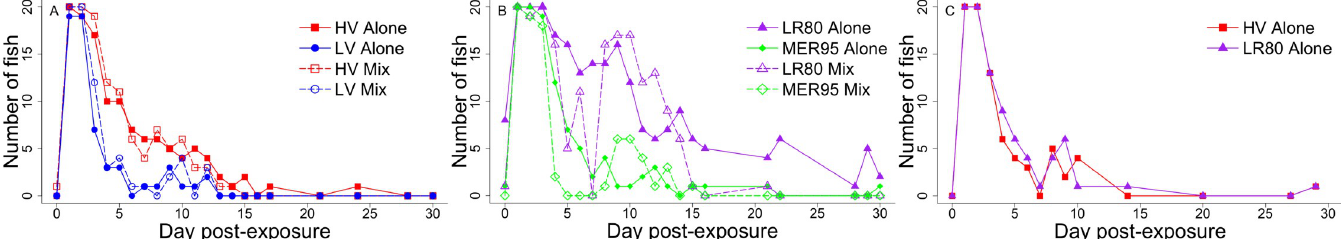
Fig 2. Number of fish shedding virus. Panels show number of remaining live fish shedding detectable quantities of IHNV RNA for genotypes HV (red), LV (blue), MER95 (green), LR80 (purple), in single (solid lines) or mixed infections (dashed lines), in experiments 1–3 (A-C, respectively). Mixed infections were not assessed in experiment 3. There were 20 total fish per treatment group. Symbols indicate time points where water samples were taken for shedding detection, measured by qPCR. Fish were excluded from the day after death onwards.